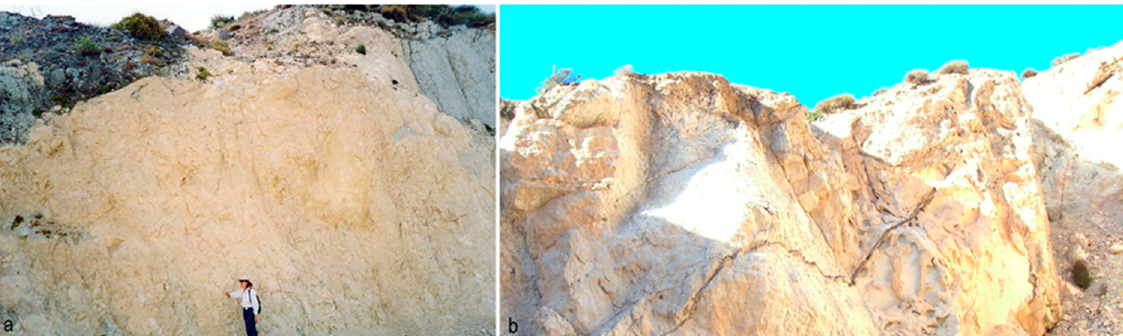
Figure 3. View of two bentonite outcrops in the south ( a ) and west ( b ) of the research area.